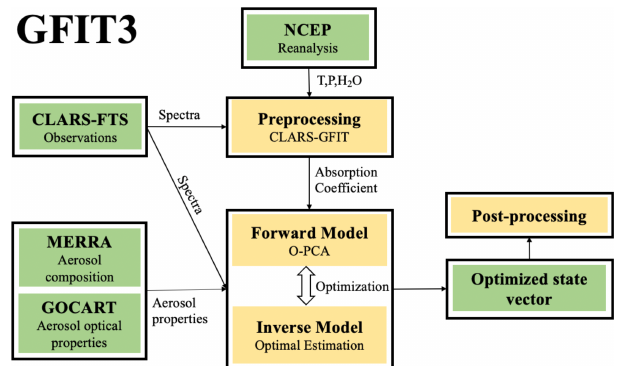
Figure 3. Workflow of GFIT3 for retrieving XCO 2 and XCH 4 from CLARS-FTS observations. There are four major components: (1) a pre-processing step to identify soundings free of clouds and heavy aerosol loading; (2) a forward RTM to generate synthetic spectra in order to simulate observed CLARS-FTS measurements; (3) an inverse model based on optimal estimation to update the surface and atmosphere states to minimize the difference between model and observation; and (4) a post-processing screening step to filter out bad